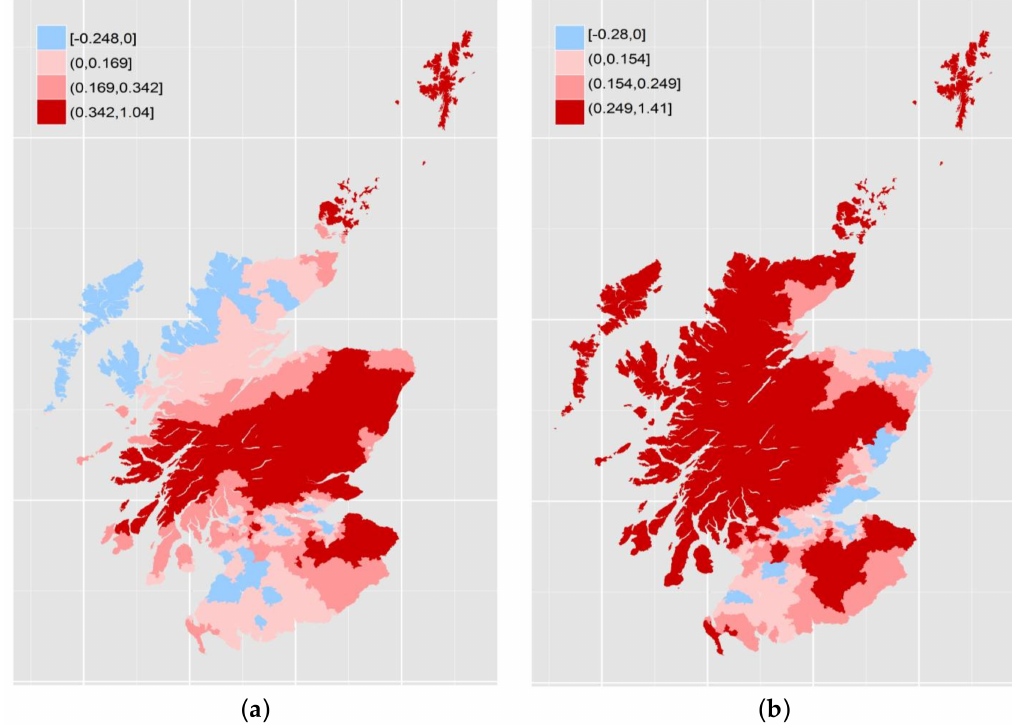
Figure 3. Local coefficients for income deprivation: 2004 ( a ); and 2012 ( b